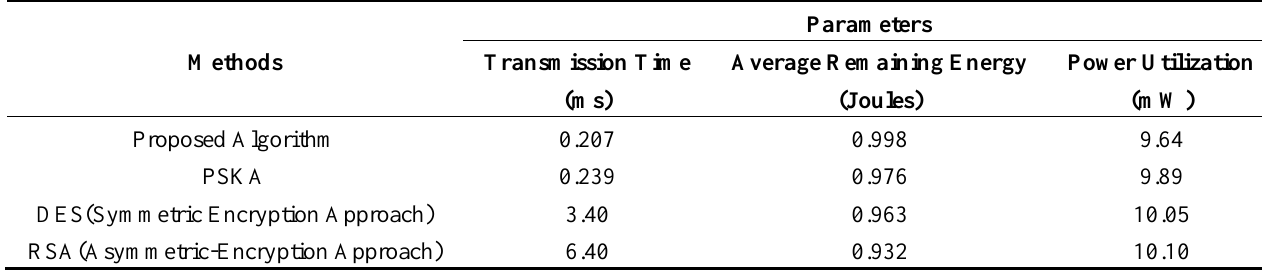
Table 3. Comparison between proposed algorithm, Physiological Signal based